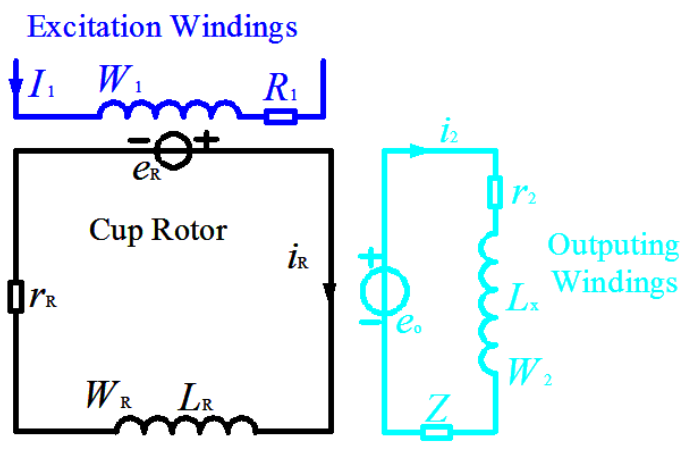
Figure 6. The equivalent circuit of the working